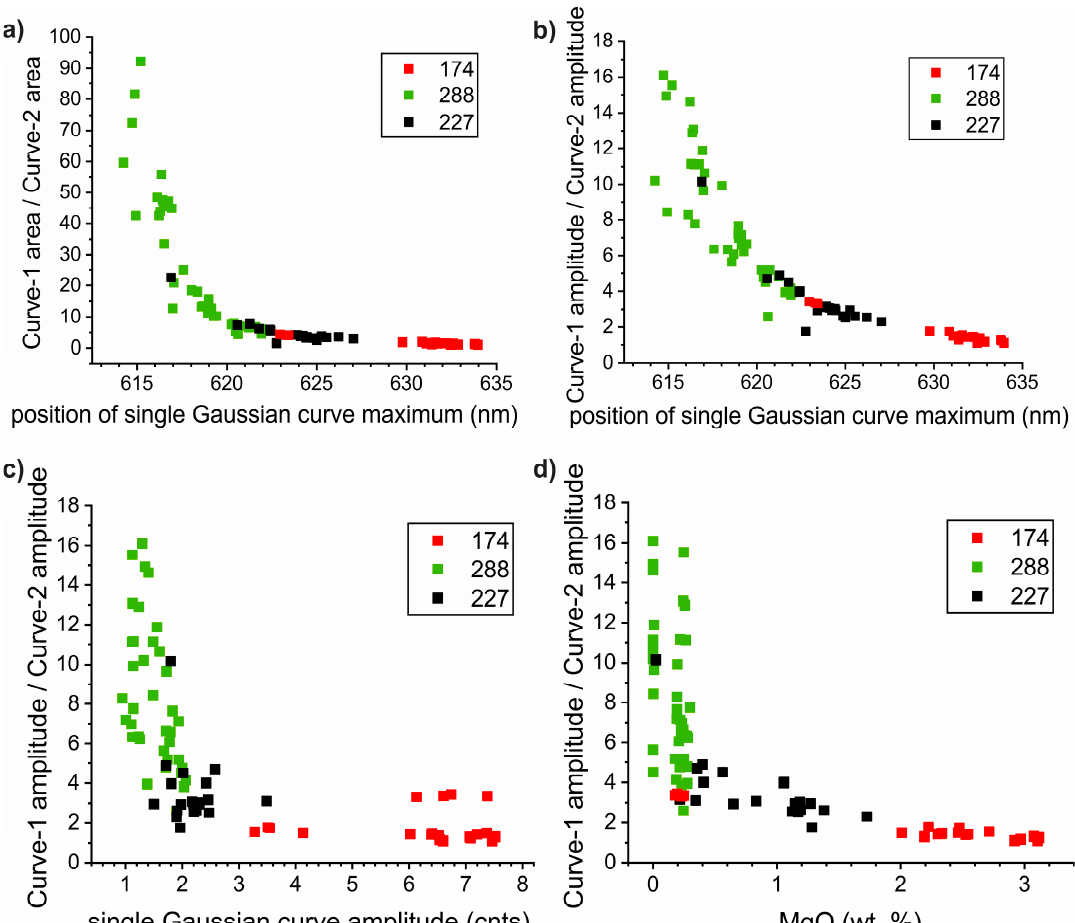
Figure 8. Overview of various parameters derived from fitting of CL-spectra of calcite by one- and two- Gaussian curves. About 10 low-intensity spectra that were difficult to fit by the two Gaussian curves were excluded from these plots. The ratio of amplitudes (intensity of extrinsic CL) or areas of curve-1 (fixed at 615 nm) and curve-2 (unfixed, >615 nm) is plotted along the vertical axis, while a similar parameter of a single Gaussian curve is plotted along the horizontal axis. ( d ) Documentation of the fact that the trends presented in figures ( a – c ) reflect an increasing admixture of Mg in the studied calcites. Note high correlation between the position of single Gaussian curve maximum and the ratio of parameters derived from two-Gaussian curves fit ( a , b ). Sample No. 174—Raspenava,